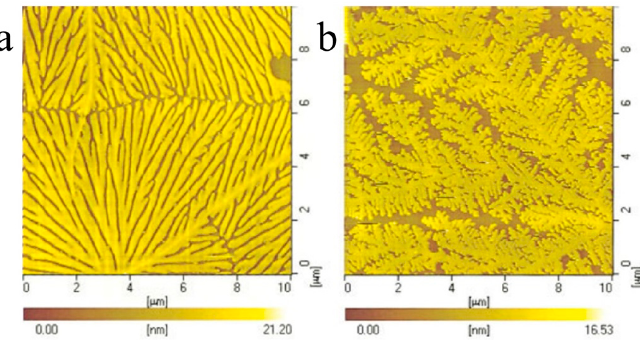
Figure 4. AFM images of PCL thin films crystallized at different temperatures: ( a ) room temperature, ( b ) 42 °C [58]. Image size: 10 × 10 μ m 2 . Copyright 2005. Reproduced with permission from John Wiley & Sons.